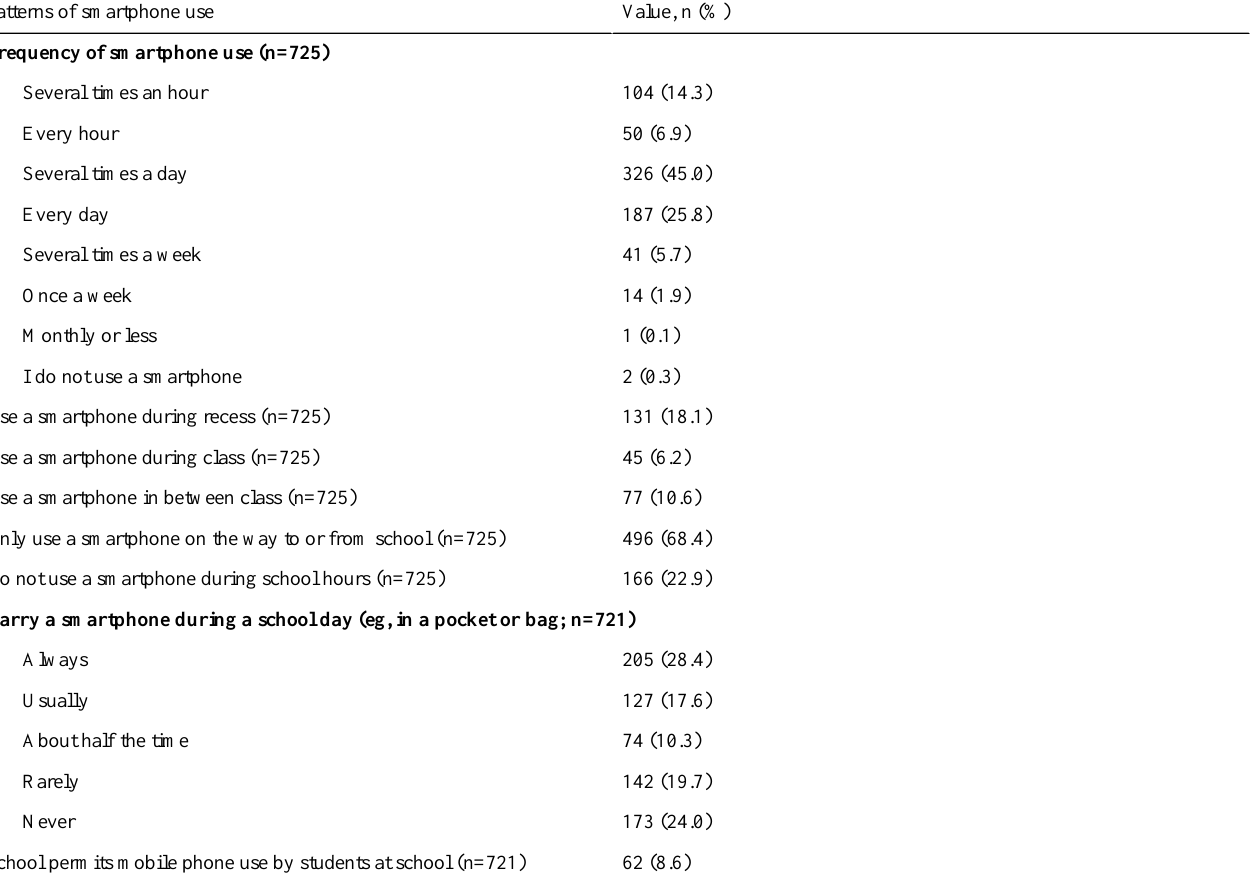
Value, n (%)Patterns of smartphone use